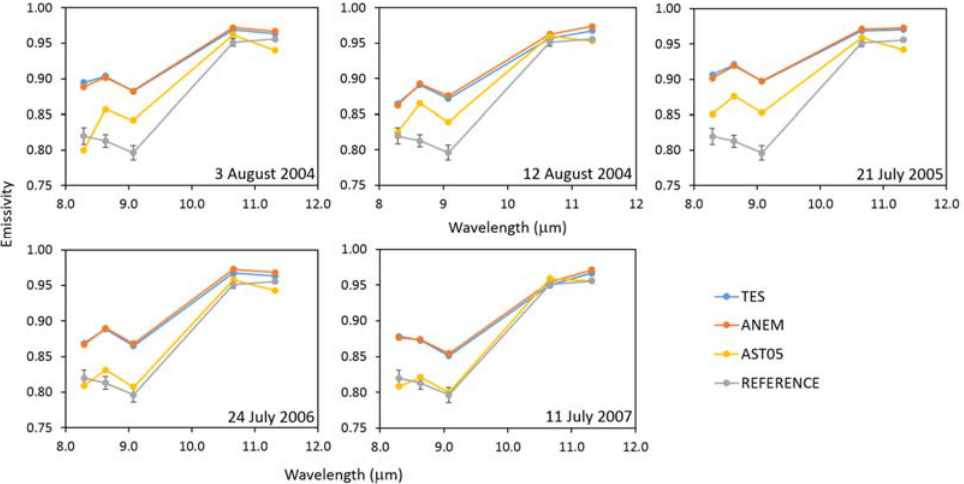
Figure 5. Sand emissivity spectra retrieved with the different methods compared to the ground reference measurements carried out on the sand beach.